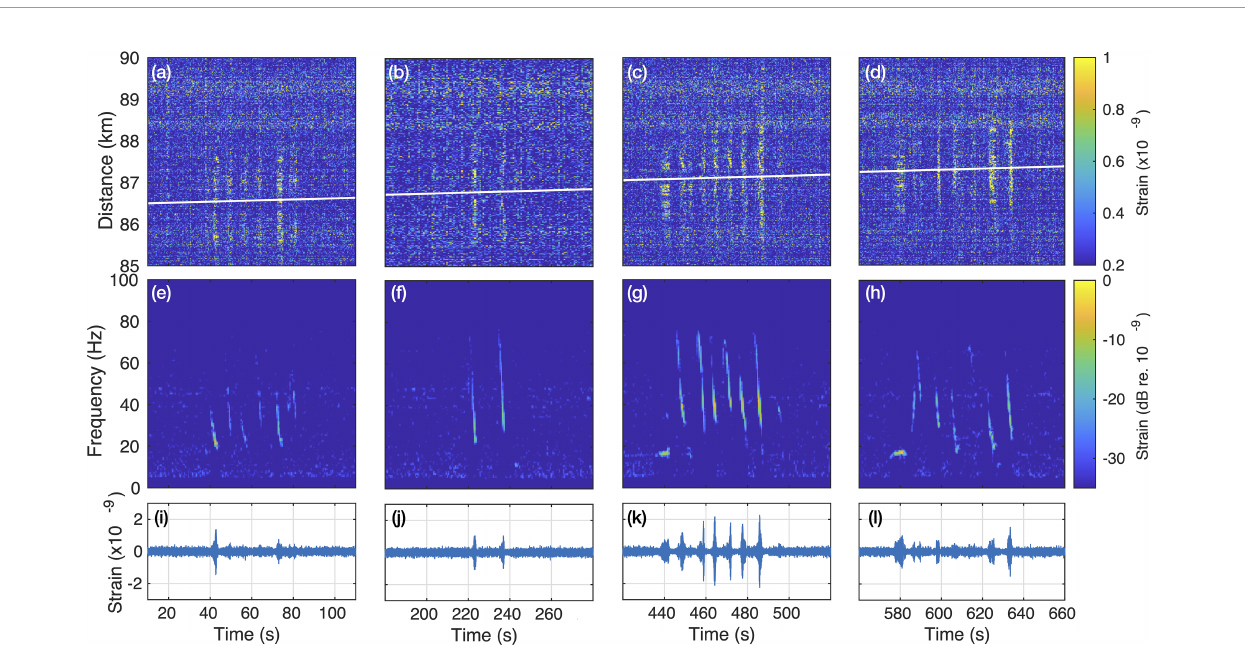
FIGURE 5 | Tracking and beamforming of series of blue whale calls recorded with a moveout on the Svalbard DAS array. (A – D) Spatio-temporal ( t - x ) representations of the recorded observation where the white line indicate the tracking of the apex, beamformed signals ’ spectrogram (E – H) and waveforms (I – L) , displayed as successive 100 s-long windows. The audio associated to (C, G, K) is available in supplementary material Audio S4